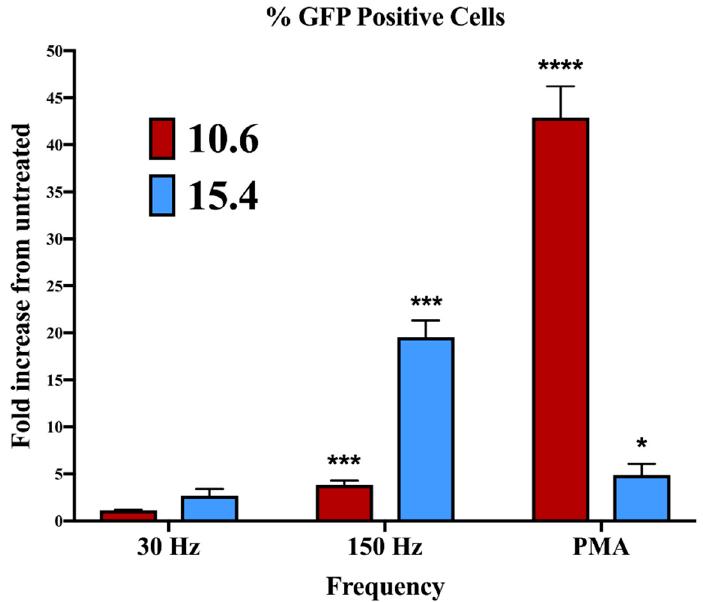
Figure 5. The magnitude of NTP-mediated stimulation of HIV-1 gene expression in J-Lat cells differs between clones. J-Lat cells were exposed to 30 or 150 Hz NTP or 100 nM PMA for 24 h prior to assessing the percentage of GFP-expressing cells by flow cytometry. Data are presented as mean ± SEM from three independent experiments. Statistical significance was calculated using a one-way Anova with Dunnett’s post-hoc test, comparing the percent of GFP-positive cells for each clone with their respective untreated control (* p < 0.05, *** p < 0.001, **** p < 0.0001).